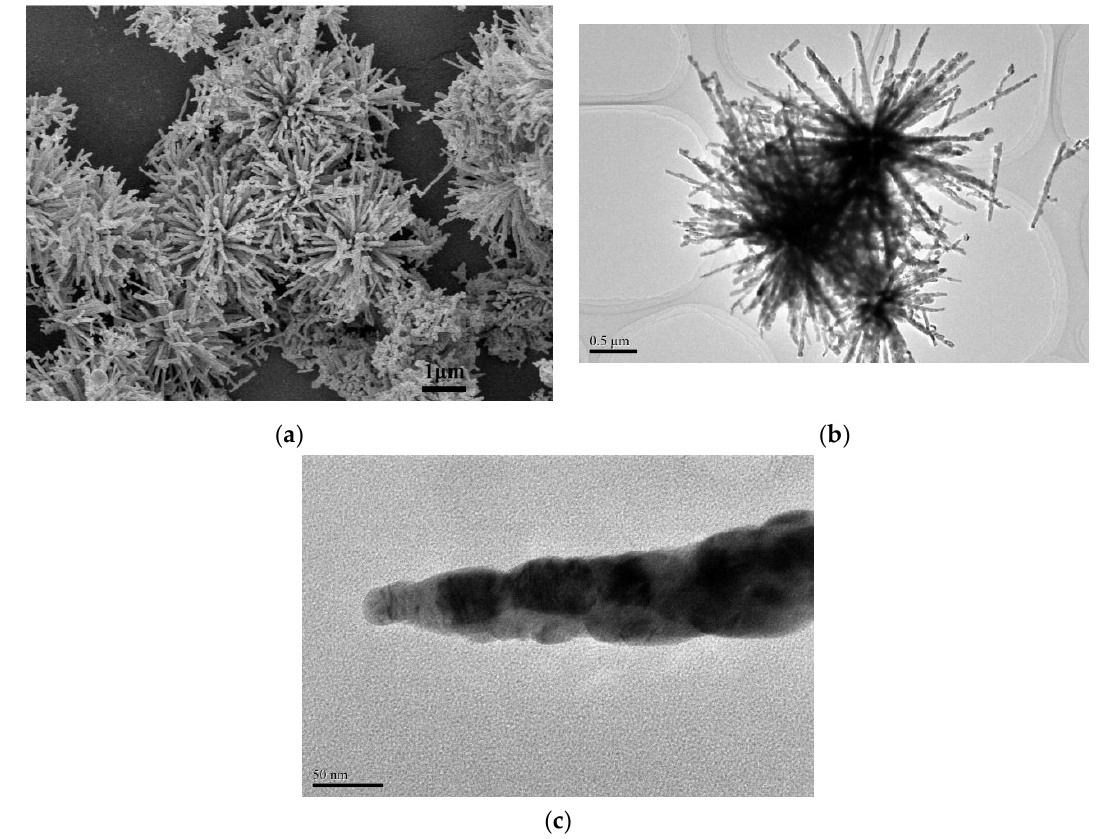
Figure 1. SEM image ( a ) and TEM images ( b , c ) of CuO-45 supports.